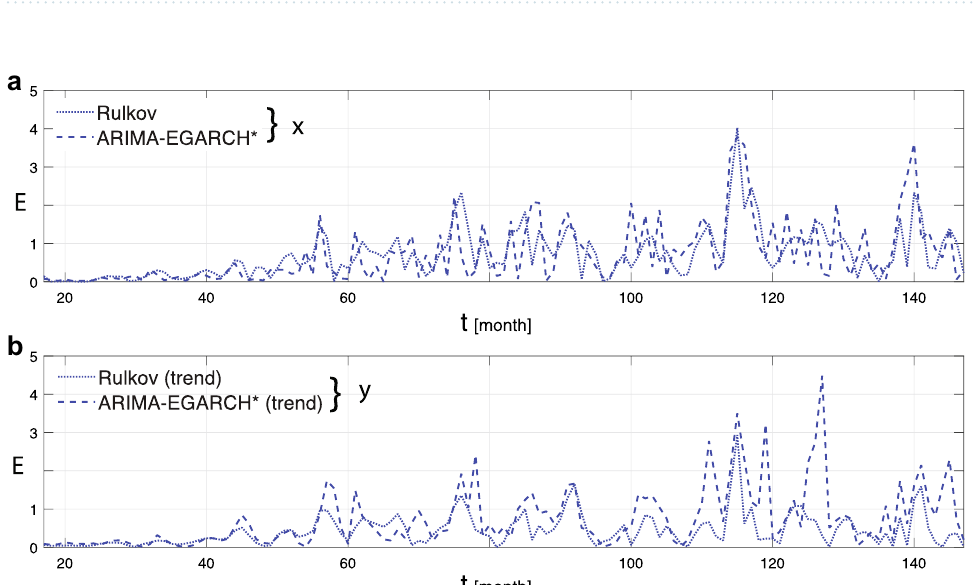
Table 2. Forecast errors: deterministic versus stochastic approach.